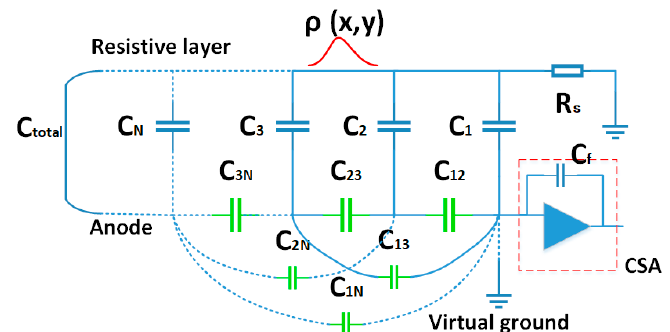
Figure 2. A lumped-parameter presentation of the readout mode for charge induction. ρ ( x , y ) is the electron cloud on the resistive layer. R s is the sheet resistance of the resistive layer. C 1 , C 2 , C 3 , to C N are the capacitance between the resistive layer and each anode strip, respectively. C 12 , C 23 , C 13 to C 1 N , C 2 N , C 3 N are the inter-electrode capacitance for each anode strip. C total is the capacitance between the resistive layer and the virtual ground.